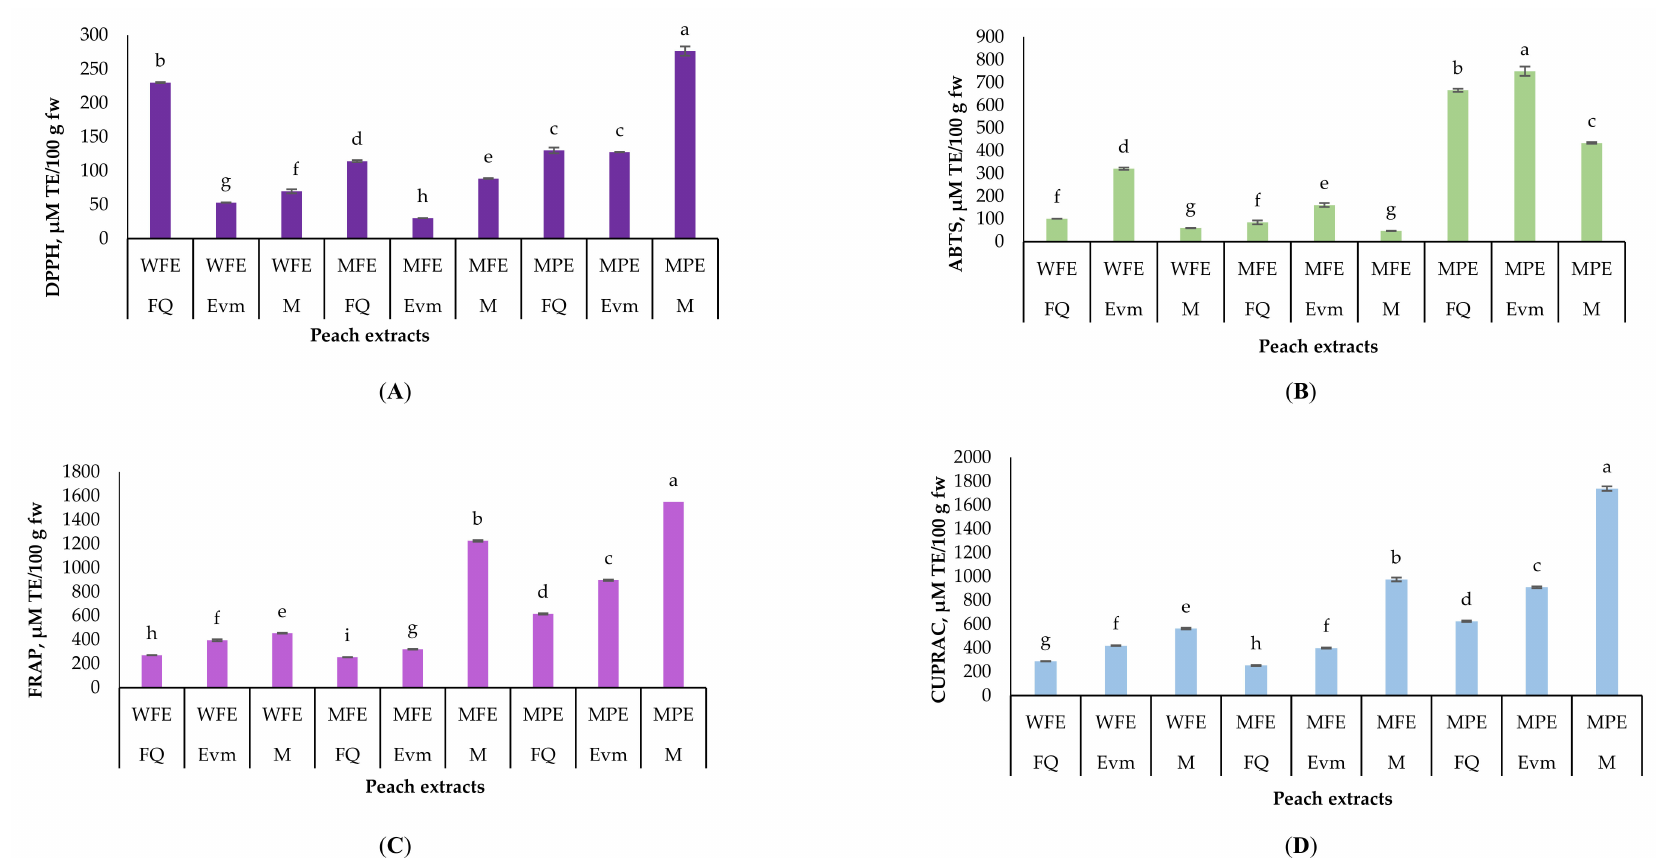
Figure 3. Antioxidant activity of late season peach ( Prunus persica L.) varieties ( µ MTE/100 g fw) by ( A ) 2,2-diphenyl-1-picrylhydrazyl (DPPH) radical scavenging activity, ( B ) 2,2 (cid:48) -azino- bis(3-ethylbenzothiazoline-6-sulfonic acid (ABTS) radical scavenging activity, ( C ) ferric-reducing antioxidant power (FRAP) and ( D ) cupric ion reducing antioxidant Capacity (CUPRAC) assays. Values are means, n = 3 per treatment group. Different letters (a–h) within chart columns indicate significant differences ( p < 0.05) between treatments as analyzed by two-way ANOVA and the Tukey test. The p -value for each treatment group (variety or extract), and their combination was less than 0.001. M—“Morsiani 90”; FQ—“Flat Queen”; Evm—“Evmolpiya” varieties. ** WFE—water peach extract, MPE—methanolic peach-peel extract, MFE—methanolic peach